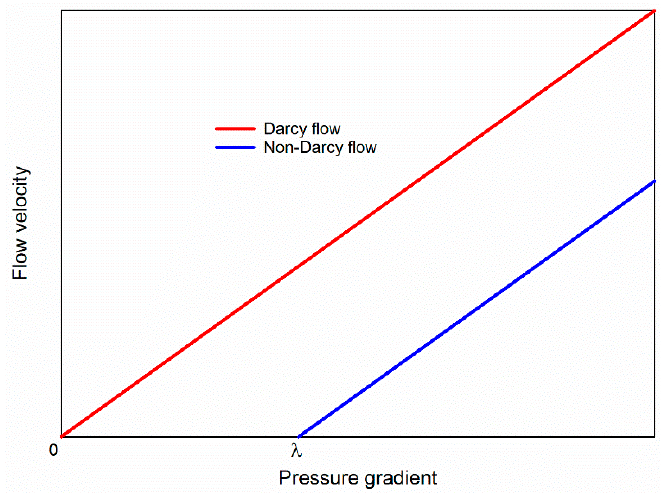
Figure 1. Schematic diagram of low velocity non-Darcy flow model.